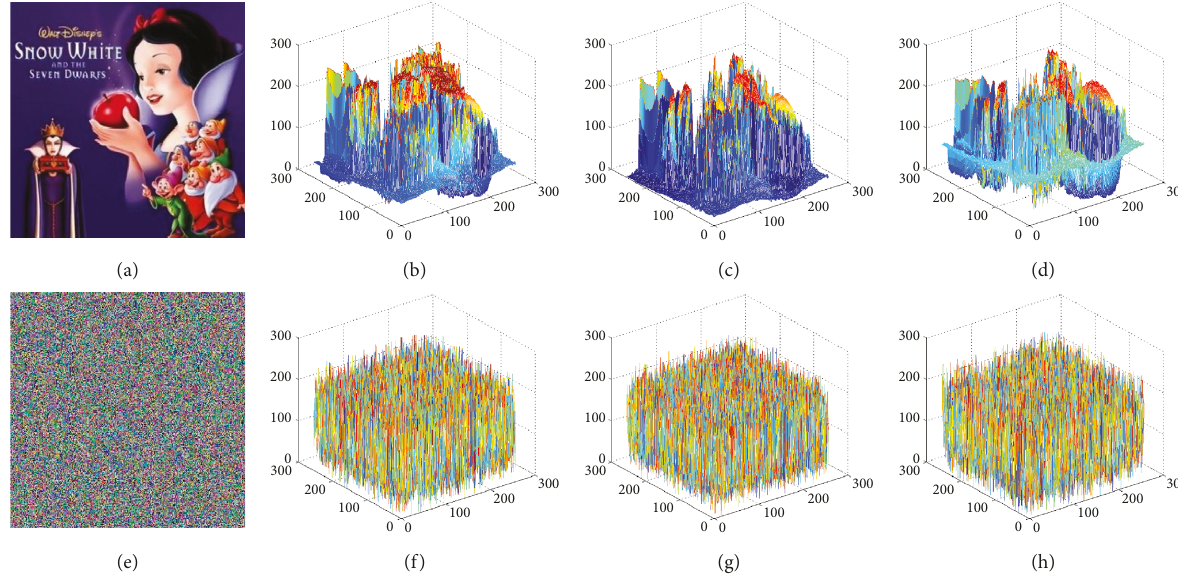
Figure 4: Histogram of color Snow White image and its encrypted image: (a) plain image; (b) histogram of red component of plain image; (c) histogram of green component of plain image; (d) histogram of blue component of plain image; (e) encrypted image; (f) histogram of red component of encrypted image; (g) histogram of green component of encrypted image; (h) histogram of blue component of encrypted image.